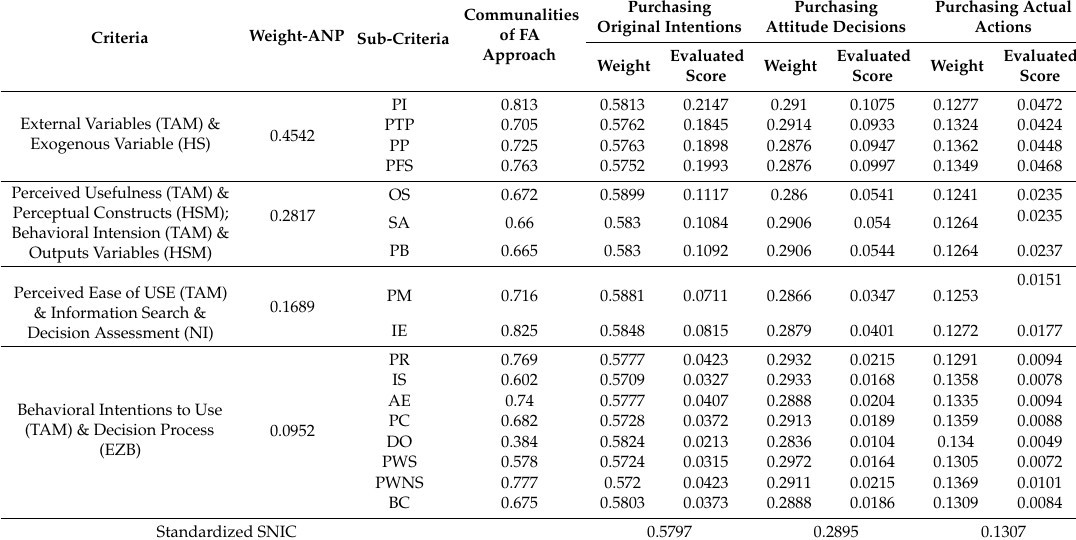
Table 5. The standardizing SCIN measurement of ANP model.